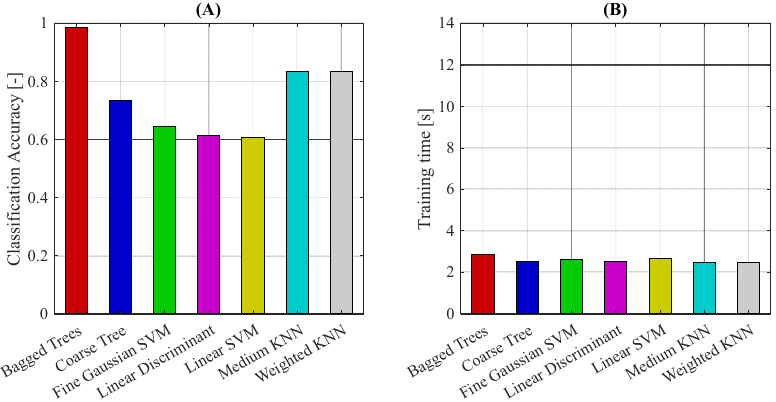
12 of 18 Figure 10. Classifier accuracy ( A ) and training time ( B ) with 13000 features (raw signal, sensor 1). All the tested classifiers had a classification accuracy of 1, which means a percentage of 100%